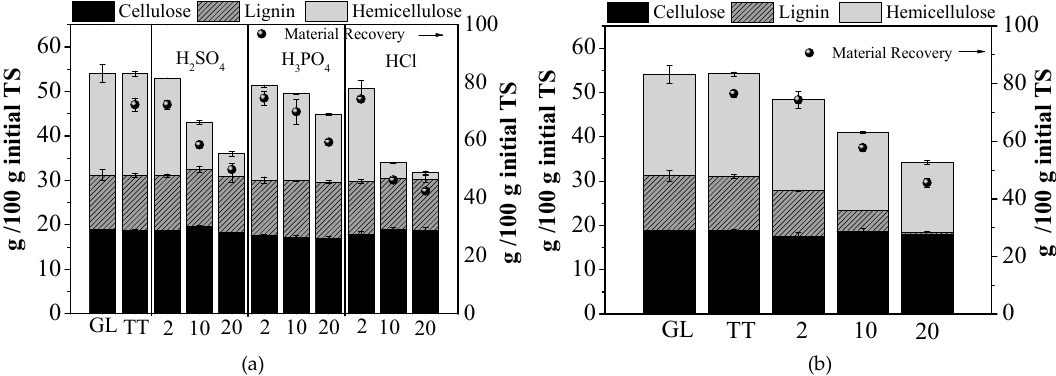
Figure 1. The effect of pretreatment on solid material recovery (right anex), as well as on the fractionation of grass lawn (GL) waste, in terms of cellulose, hemicellulose and lignin, during ( a ) thermal treatment (TT) at 120 °C for 1 h and acid (H 2 SO 4 , H 3 PO 4 , HCl) pretreatment, at the concentrations of 2, 10 and 20 g/100 gTS; ( b ) TT at 80 °C for 24 h and alkali (NaOH) pretreatment at the concentrations of 2, 10 and 20 g/100 gTS, respectively.